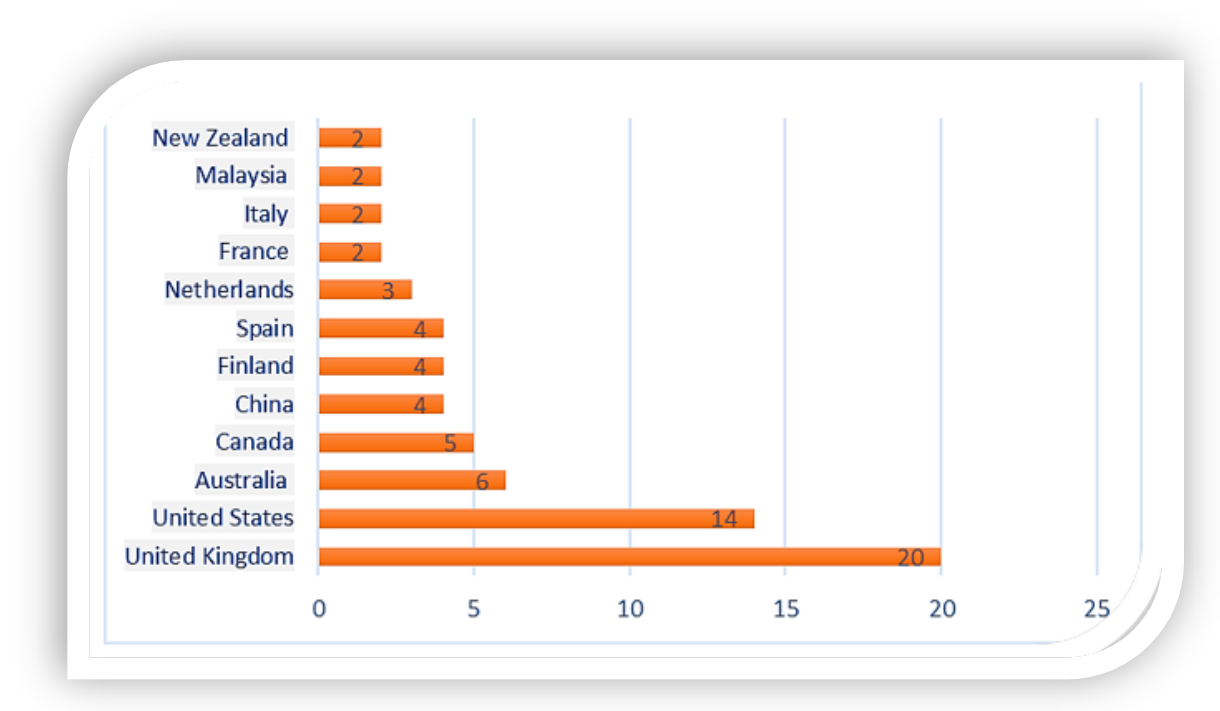
Figure 3. Geographical Distribution of Publications.